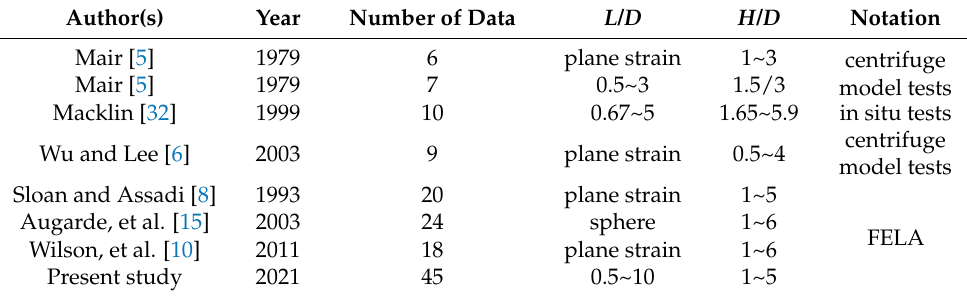
Table 1. Database of the tunnel/sinkhole stability number ( L / D ≥ 0.5).